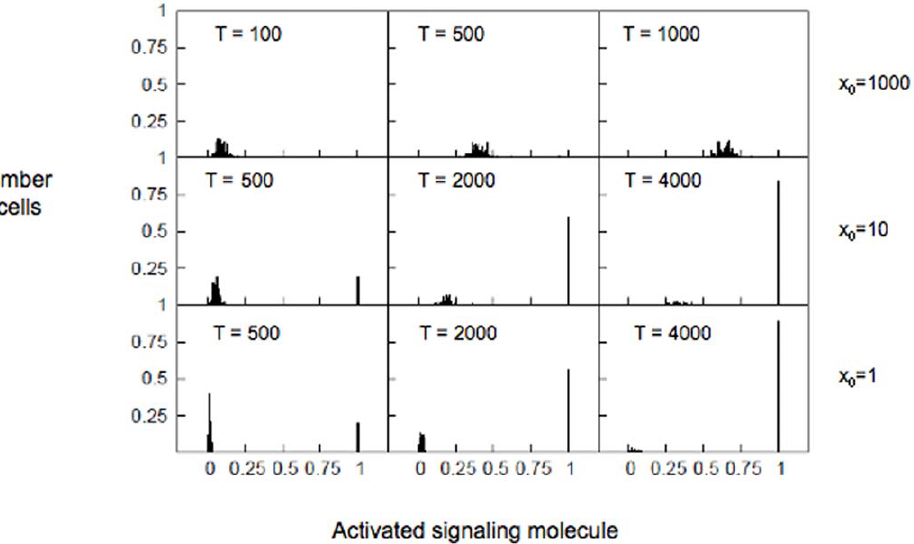
Figure 4. Probability distribution as a measure of cell-to-cell stochastic variability. Probability distribution of activated x 3 molecules under strong x 0 ~ 1000 (top) , intermediate x 0 ~ 10 (middle), and weak x 0 ~ 1 (bottom) stimuli. Histograms were obtained using single cell X 3 activation data from a population of 100 cells. For the strong stimulus (top) probability distributions are shown for three time points T=100, T=500, and T=1000. For the intermediate stimulus (middle), probability distributions are shown for three time points T=500, T=2000, and T=4000. For the weak stimulus (bottom), probability distributions are shown for three time points T=500, T=2000, and T=4000.